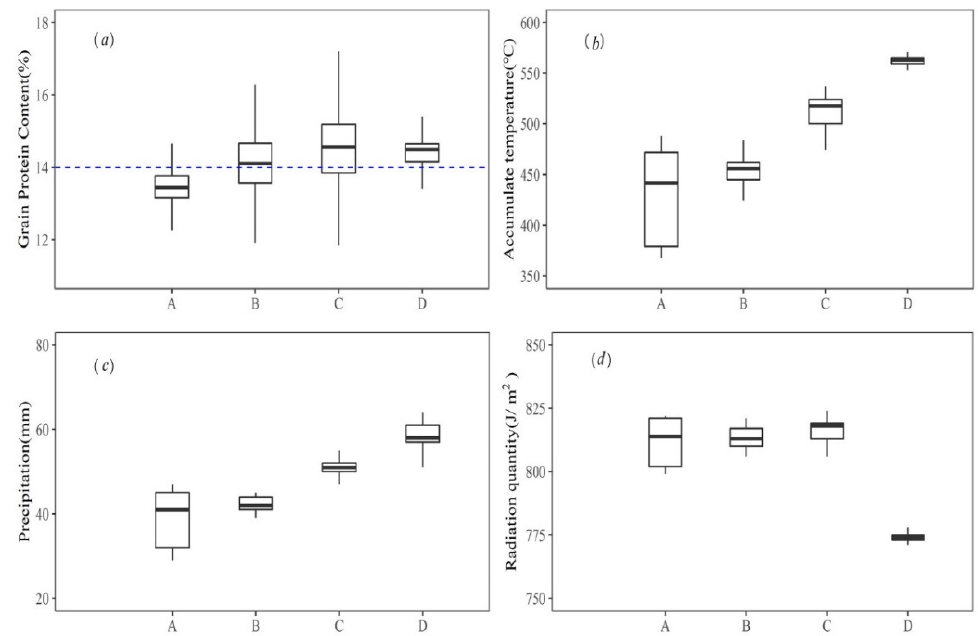
Figure 10. Statistical box map of grain protein content and meteorological data: ( a ) grain protein content; ( b ) accumulate temperature; ( c ) precipitation; ( d ) radiation quantity. A denotes four districts, namely, Yanqing, Pinggu, Miyun, and Huairou, in the northern mountainous area of Beijing; B denotes two districts, namely, Changping and Shunyi, with relatively flat topography in central Beijing; C denotes three districts, namely, Fangshan, Daxing, and Tongzhou, in the south of Beijing; and D denotes Renqiu City.